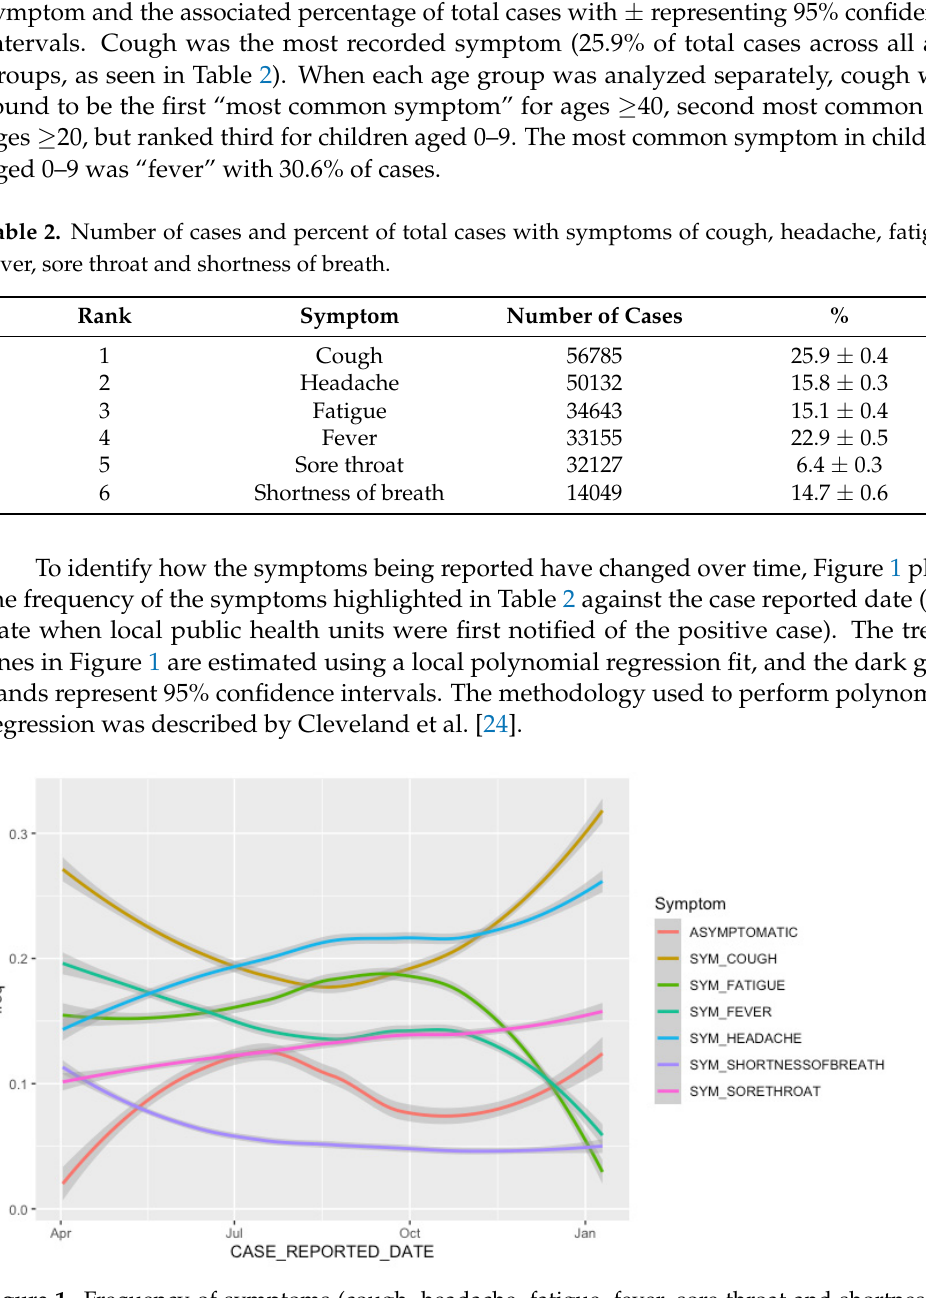
Figure 1. Frequency of symptoms (cough, headache, fatigue, fever, sore throat and shortness of breath) and asymptomatic cases. breath) and asymptomatic